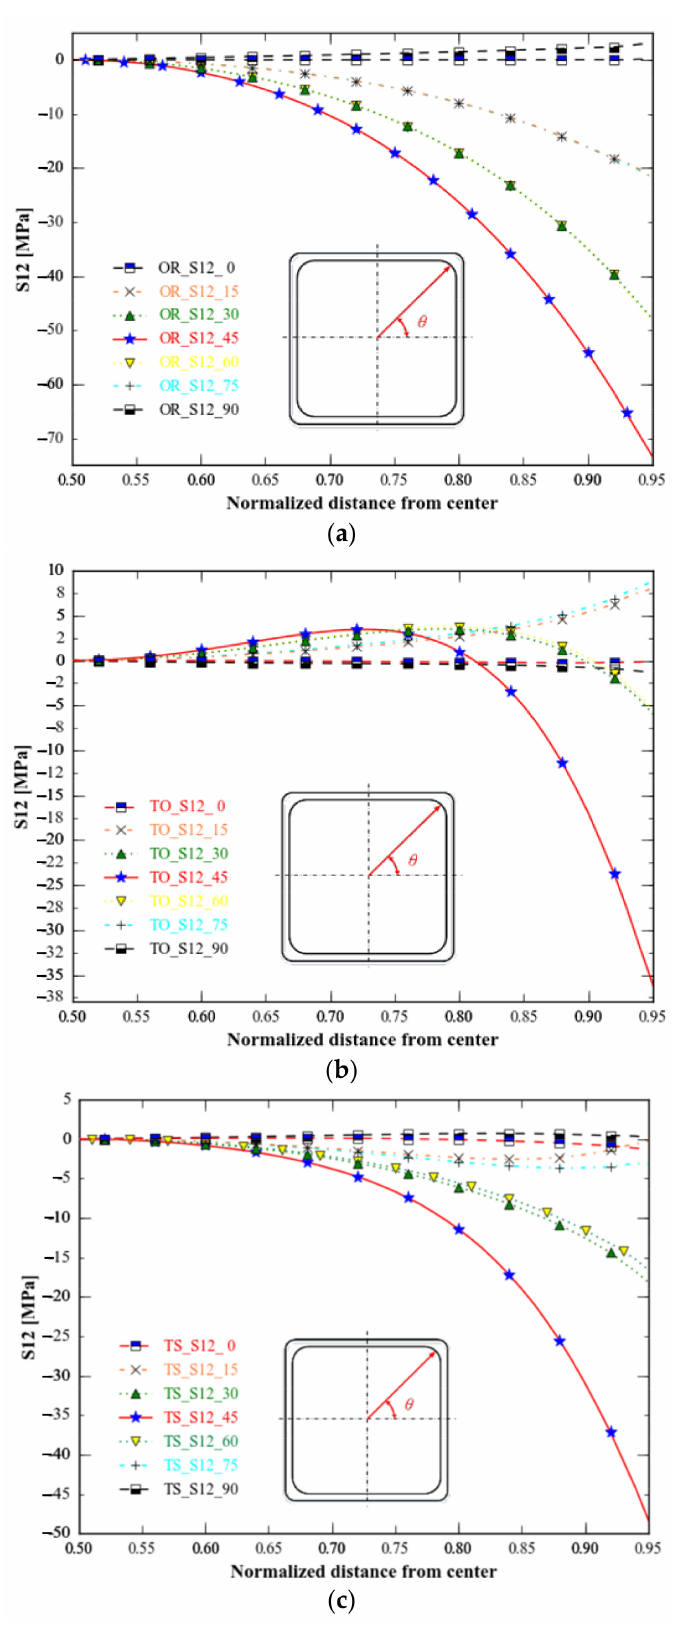
Figure 16. S 12 of the three specimens in nine directions. ( a ) Type-A: unoptimised specimen; ( b ) type B: specimen with topology-only optimization; ( c ) type C: specimen with topology combined with shape